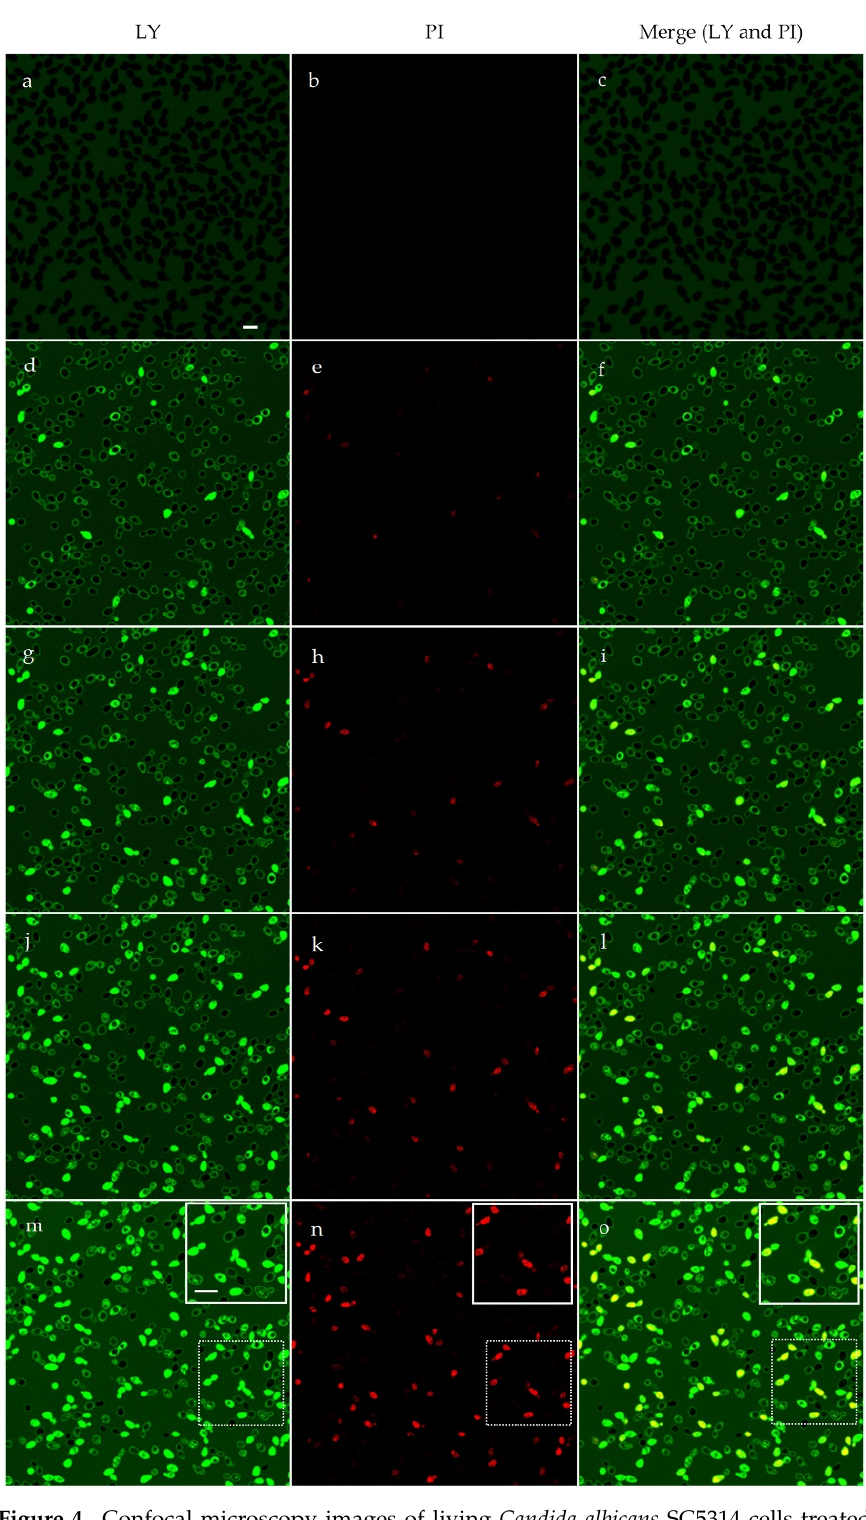
Figure 4. Confocal microscopy images of living Candida albicans SC5314 cells treated with Ma2. ( a – c ) Yeast cells, pre-treated with propidium iodide (PI) and lucifer yellow (LY), were treated with Ma2. Images were taken after ( d – f ) 10 min, ( g – i ) 20 min, ( j – l ) 30 min, and ( m – o ) 60 min. The same field is shown. Over time, LY is increasingly evidenced inside yeast cells, with subsequent internalization of PI, suggesting an irreversible membrane permeabilization induced by the peptide, eventually resulting in cell death. Prior to internalization, LY is localized at the cell wall level. The inset in panels ( m – o ) shows a detail of the field highlighted by dotting. Bar, 10 µm.